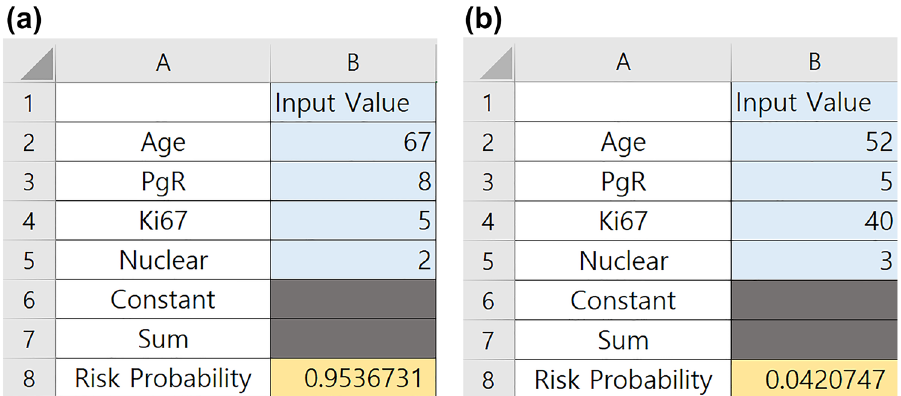
Figure 3. Automatic calculator using Microsoft Excel worksheets. ( a ) 95% probability of low Mammaprint risk with age 67, strong PR (8), low Ki67 (5%) and tumor grade 2. ( b ) 4% probability of low Mammaprint risk with age 52, intermediate PR (5), high Ki67 (40%) and high tumor